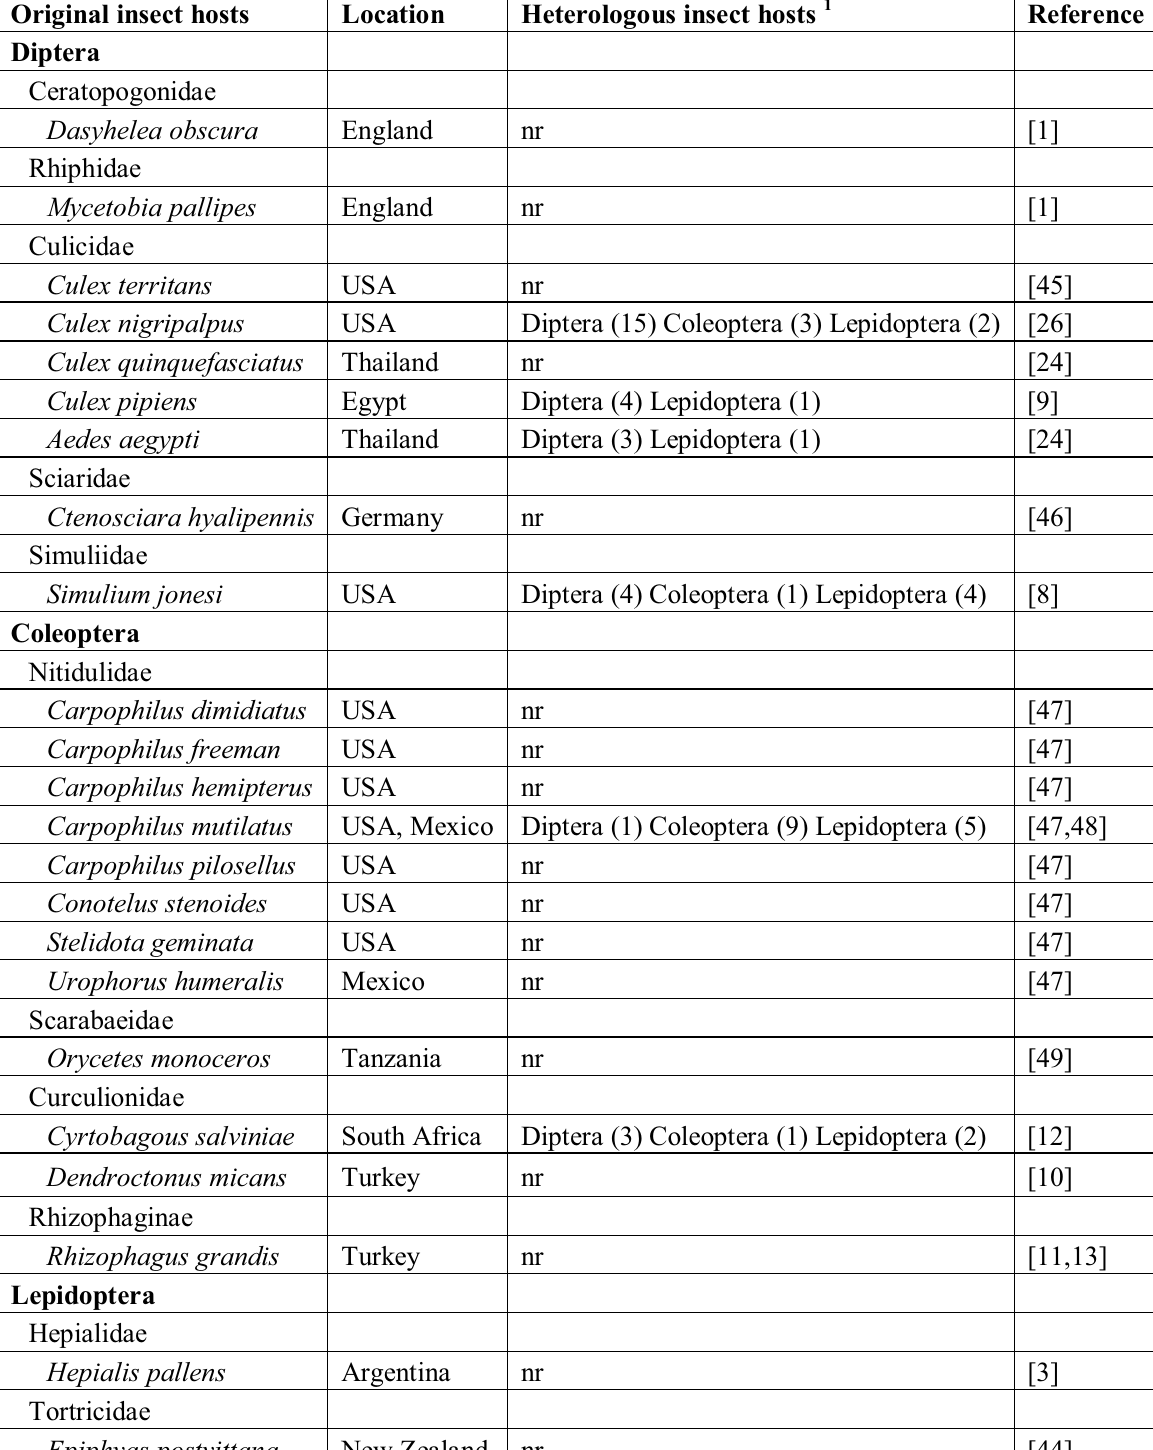
Table 1. Reported insect host record for Helicosporidium